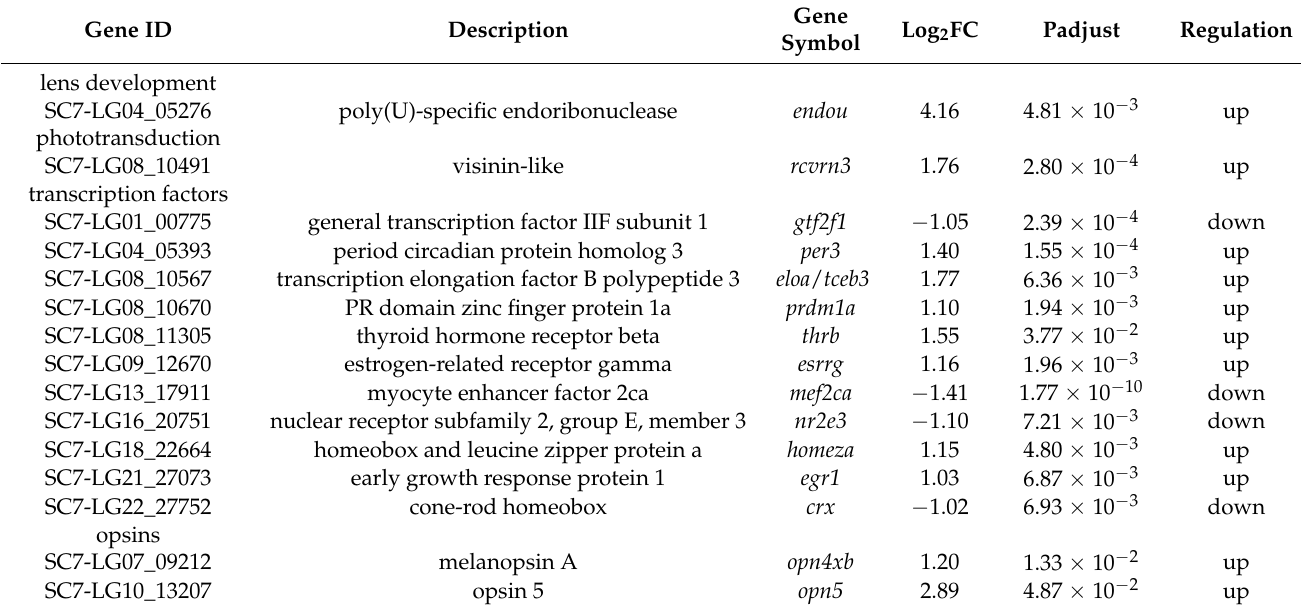
Table 2. Representative DEGs between the mandarin fish larvae fed with live prey fish and brine